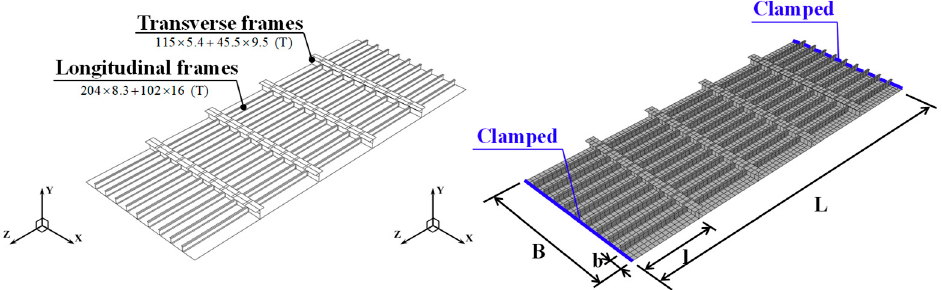
Figure 4. Stiffened plate FE model.